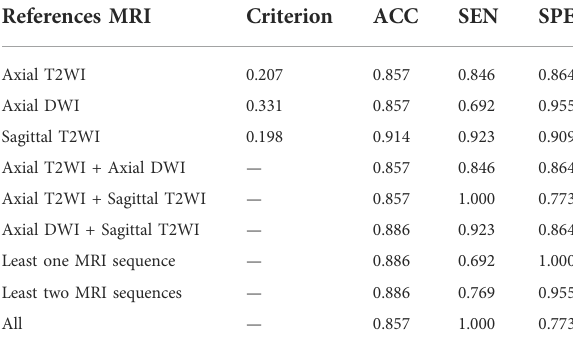
TABLE6TheperformanceofTURinsingleMRIsequenceandMultiple MRI